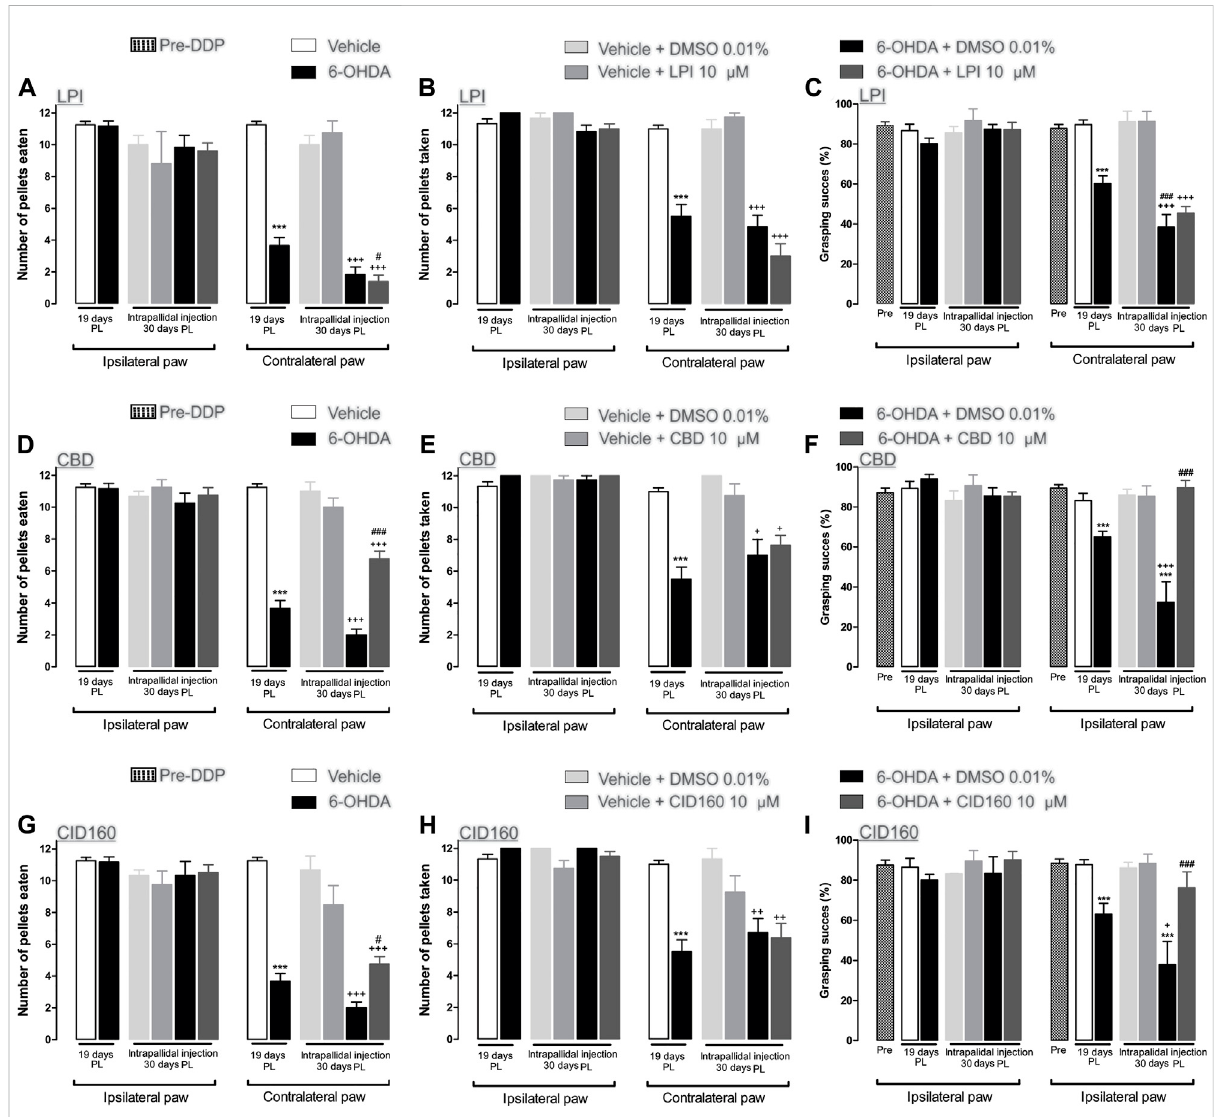
The CBD and CID160 administered in the GPe generated superior forelimb performance in the staircase test. The number of pellets eaten, the number of pellets taken, and the percentage of grasping success were recorded on the 19th day post-lesion. The GPR55r agonist LPI (10 µM) (A – C) , theinverseagonistCBD(10 µM) (D – F) ,andtheselectiveantagonistCID16010 µM (G – I) wereadministeredviaintrapallidalinjectiononthe30thday. It is shown that the 6-OHDA + CBD and 6-OHDA + CID160 groups increase the indices of motor performance in contrast with the 6-OHDA + LPI and 6-OHDA + DMSO groups.Data are representedasgroup mean± SEM. *** p < 0.001 vs . vehicle; + p < 0.05, ++ p < 0.01, +++ p < 0.001 vs . vehicle + DMSO 0.01%; # p < 0.05, ### p < 0.001 vs . 6-OHDA + DMSO 0.01%; a one-way ANOVA followed by a Tukey post-hoc test, ( n = 5 –